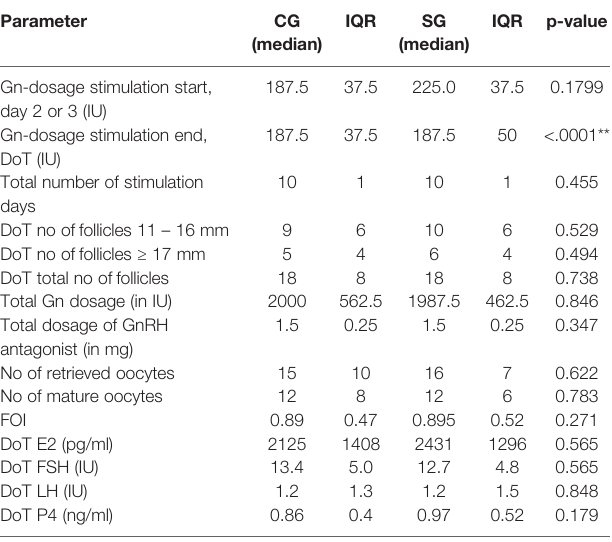
TABLE 2 | Stimulation parameters.